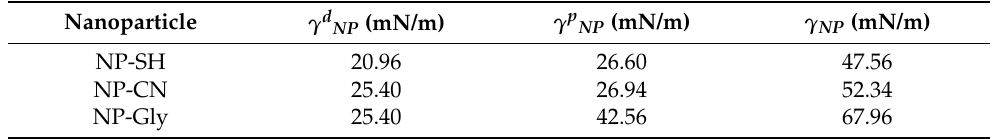
Table 2. Surface energy (interfacial energy of the nanoparticles with air) γ NP and its disperse γ d and polar component, γ p of the silica nanoparticles with water, bearing different surface functional NP groups. The data for NP-CN and NP-SH were taken from reference [35].